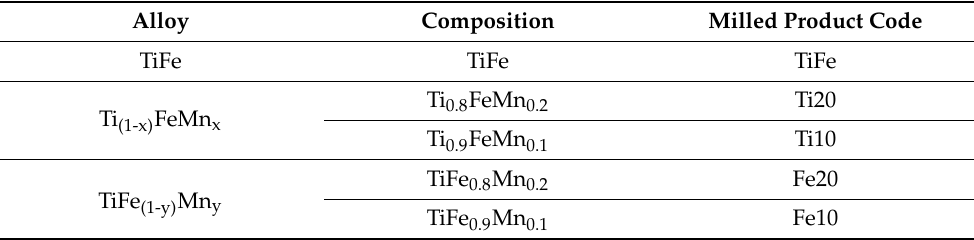
Table 2. Compositions of the binary and ternary milled products produced and their related codes.